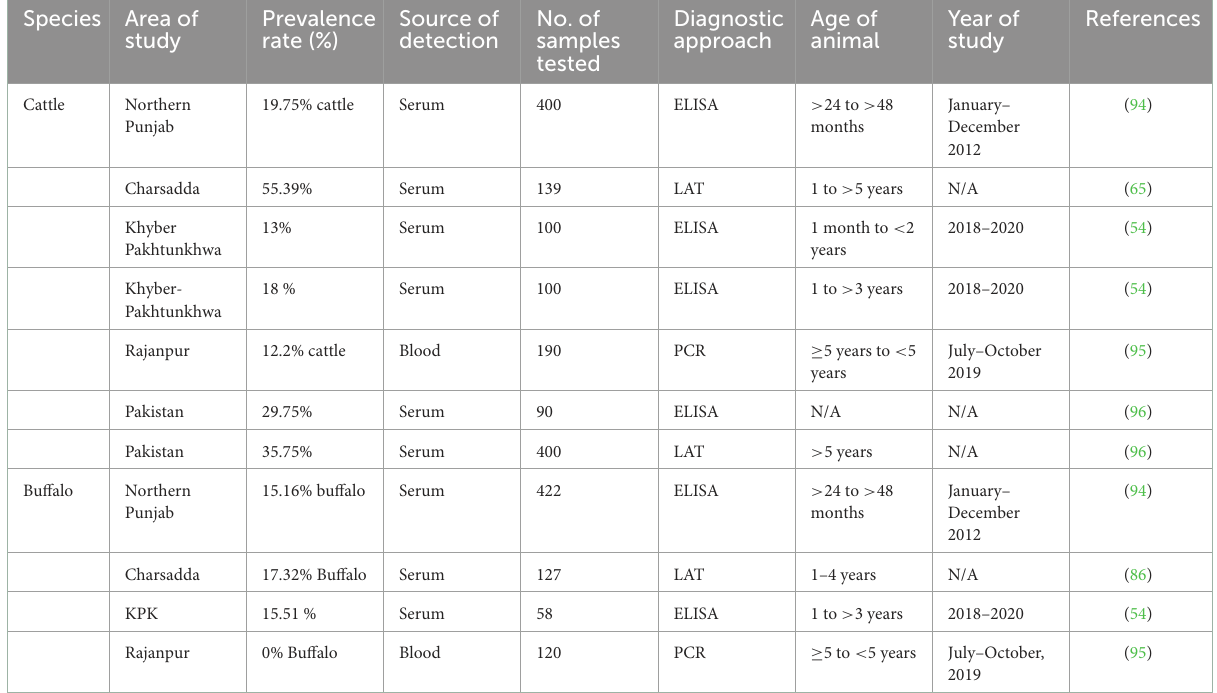
TABLE 4 Reported prevalence of Toxoplasma gondii in large ruminants (cattle and buffalo) in Pakistan. Species Area of